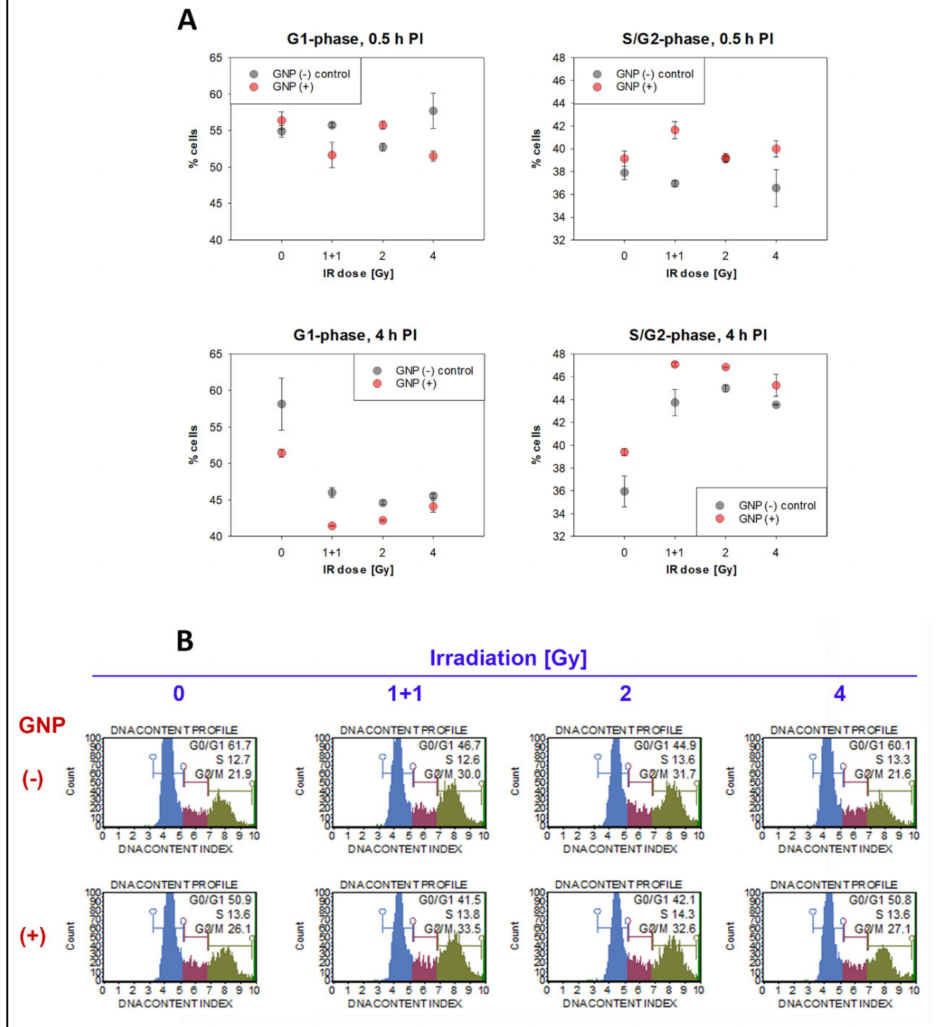
Figure 12. Flow cytometry analysis of cell cycle distribution of SkBr3 cells in dependence of the irradiation dose and GNP incubation (0.4 µ g/mL for 18 h). ( A ) The mean values ( ± SE) of G1 vs. S/G2/M cells for all treatments and their combinations. Controls without GNP: gray symbols, GNP-treated cells: red symbols ( B ) Examples of raw flow cytometry data for non-irradiated control SkBr3 cell specimens incubated (+) or not incubated ( − ) with GNPs and these specimens examined 4 h after exposure to the indicated doses of γ -rays. The conditions of GNP incubation were the same as in A. Cell populations in specific phases of the cell cycle are labeled as follows: G0/G1—blue, S—purple,